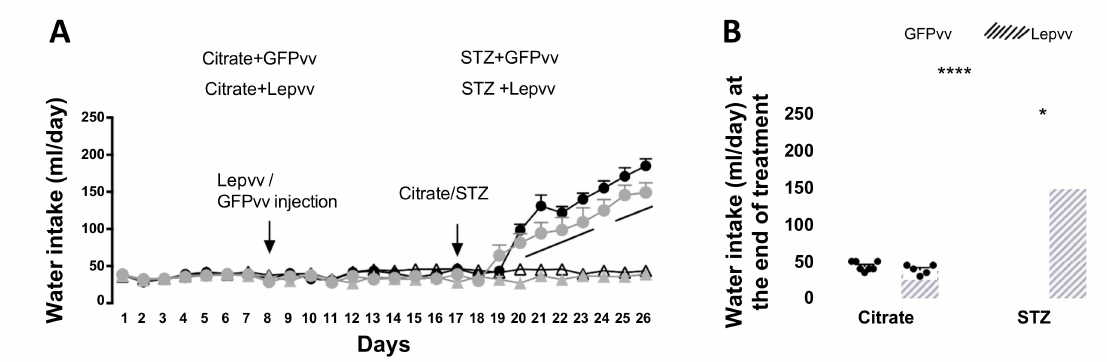
Figure 2. Water intake changes in male rats that were injected with Lepvv or GFPvv on day 8 followed by injection with citrate buffer or STZ (to induce diabetes) on day 17. ( A ) Profile of water intake (mL/day, mean ± SEM) in diabetic and